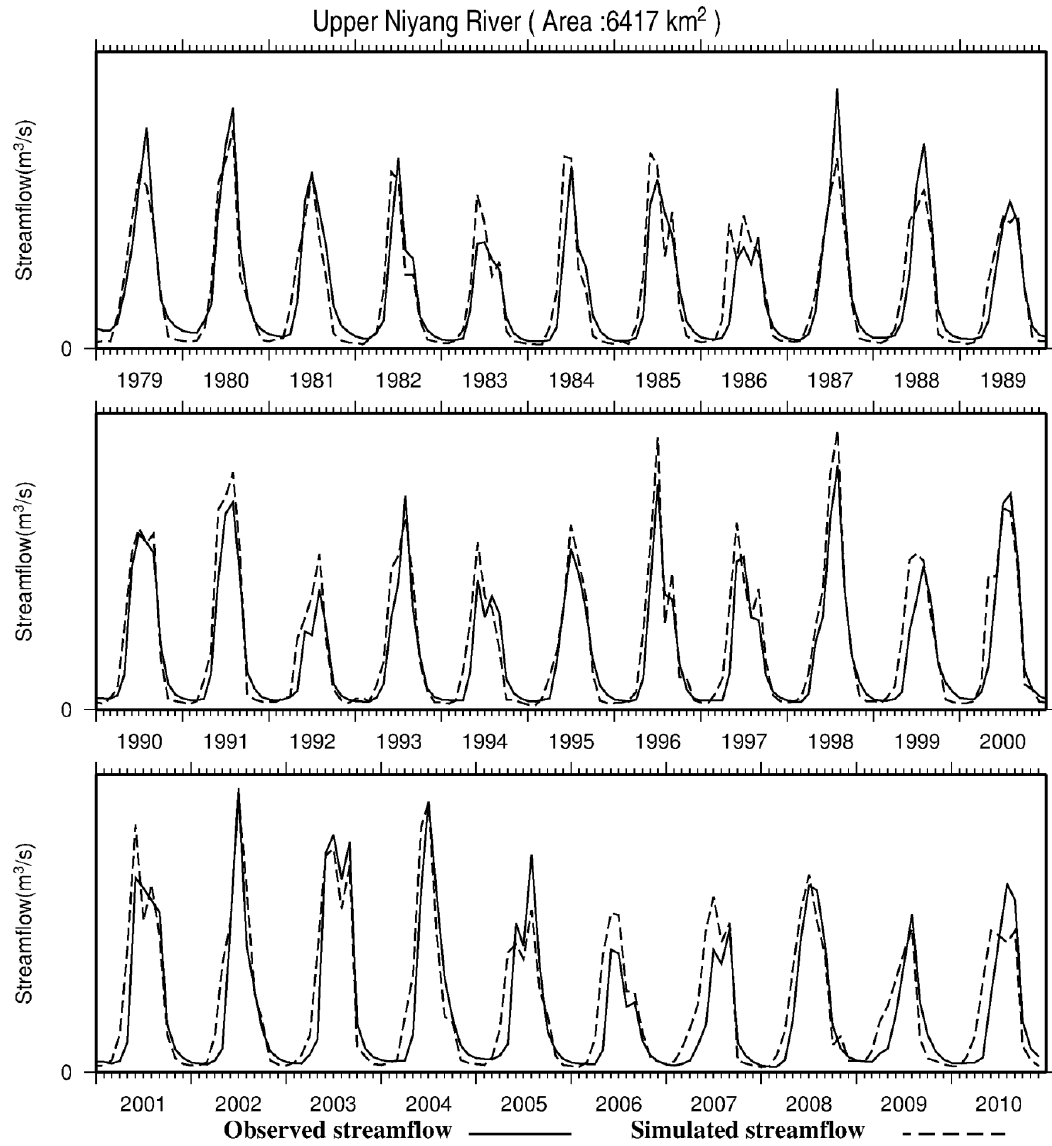
Figure 3. Simulated and observed monthly runoff for the period 1979–2010 in the upper Niyang River Basin. 1979–1995 and 1996–2010 are the calibration and validation periods, respectively.